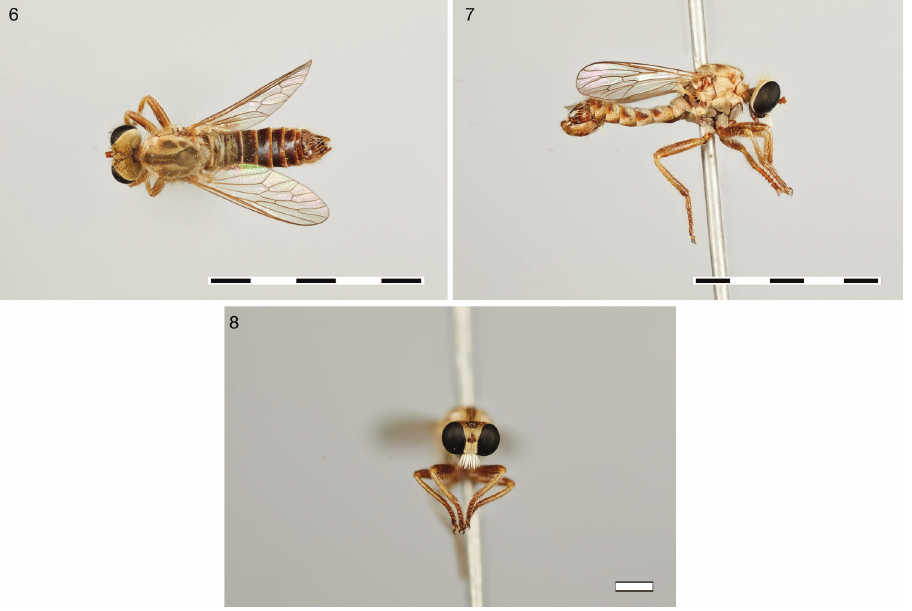
Figures 6–8. Microphontes ericfisheri sp. n. ( ♂ Holotype, USNMENT01115122): 6 dorsal (Morphbank #861782) 7 lateral (#86178) 8 head anterior (#861787). Scale bar : 5 mm ( 6–7 ), 1 mm ( 8